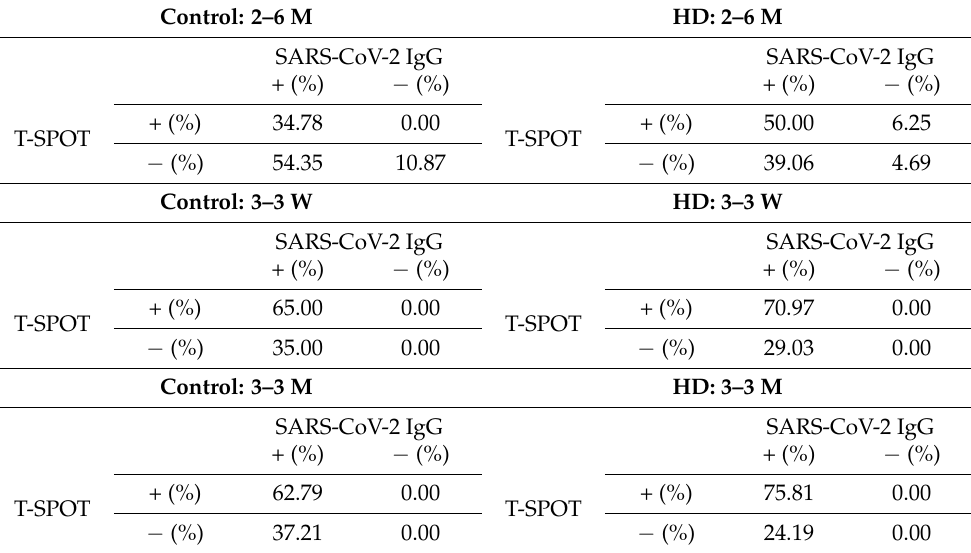
Table 4. Contingency table of T-SPOT results and SARS-CoV-2 IgG levels.